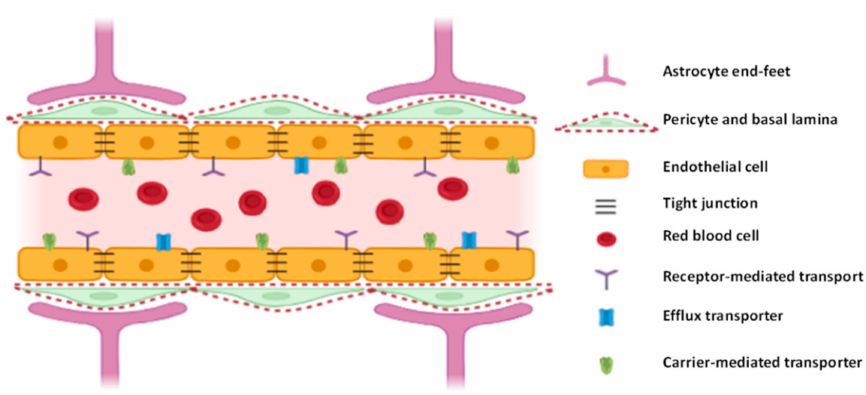
Figure 1. Key components of the blood-brain barrier. Adapted from